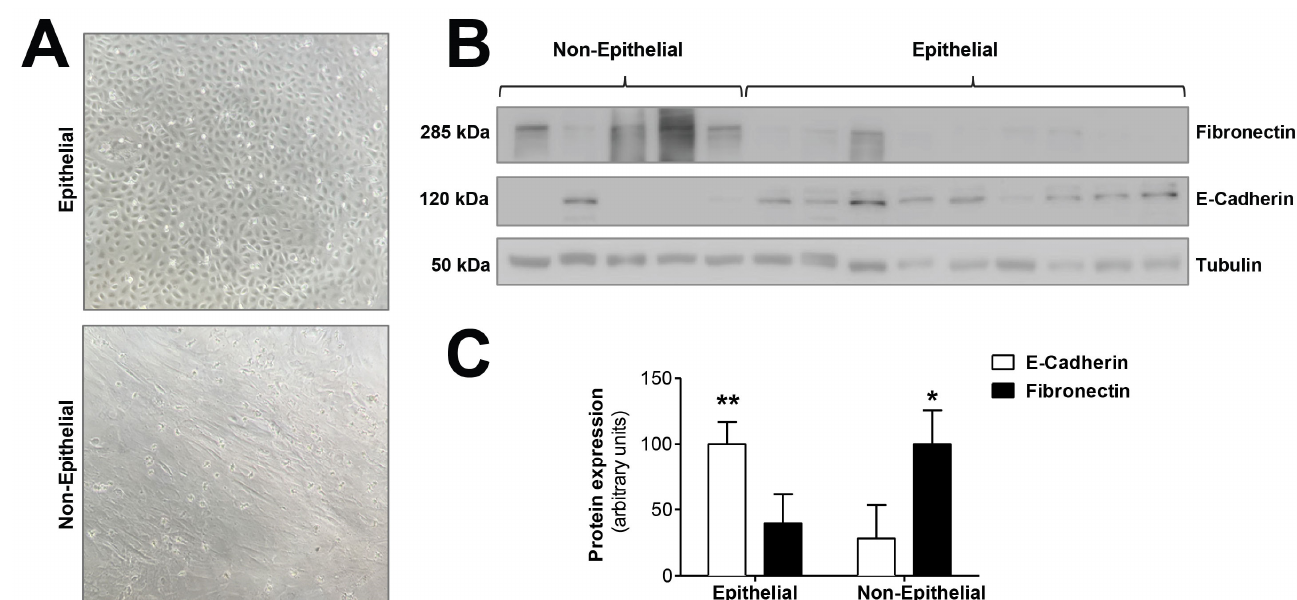
Figure 1. Epithelial-to-mesenchymal transition of mesothelial cells during PD. ( A ) Phase-contrast microscopy showing different morphologic characteristics of mesothelial cells with epithelial and non-epithelial phenotypes. Original magnifi- cation ×10. ( B ) Western blot showing the expression of typical markers of epithelial-to-mesenchymal transition, E-cadherin (epithelial marker) and fibronectin (mesenchymal marker). ( C ) The graph shows the mean ± SEM levels of expression in nine epithelial samples and five non-epithelial samples; ** p < 0.01 and * p < 0.05 vs. non-epithelial and epithelial cells, respectively. PD: peritoneal dialysis.